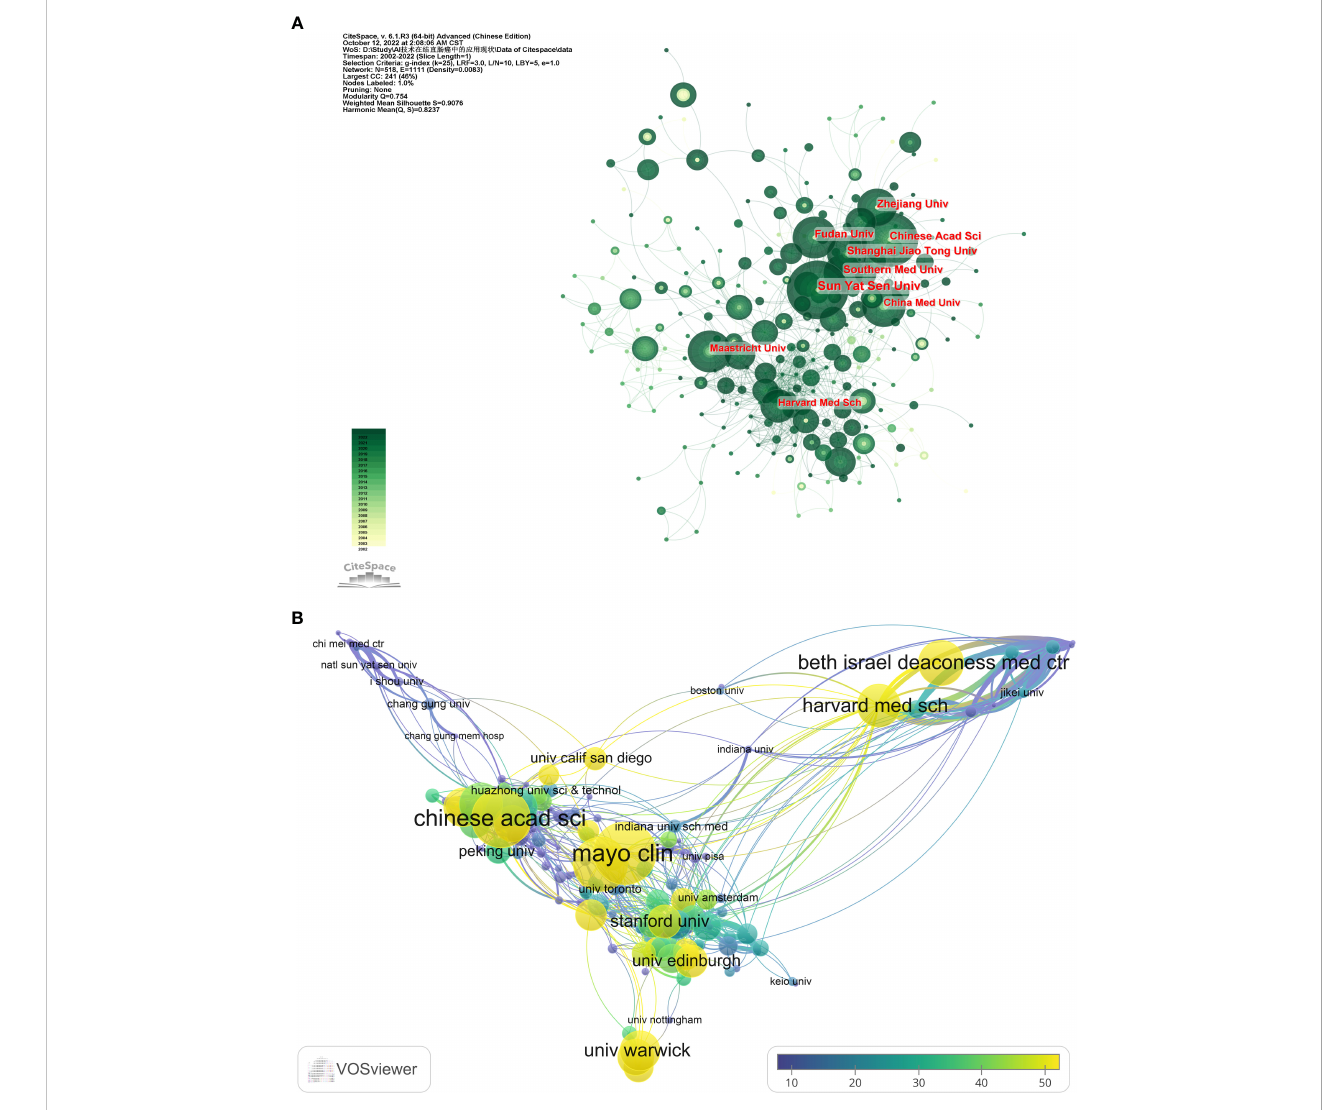
FIGURE 5 Cooperation and citations between institutions. (The circle size represents the number of articles issued by the institution. Connecting lines represent the intensity of collaboration between institutions.). (A) Cooperation among institutions. (B) Average citations per article by different institutions.